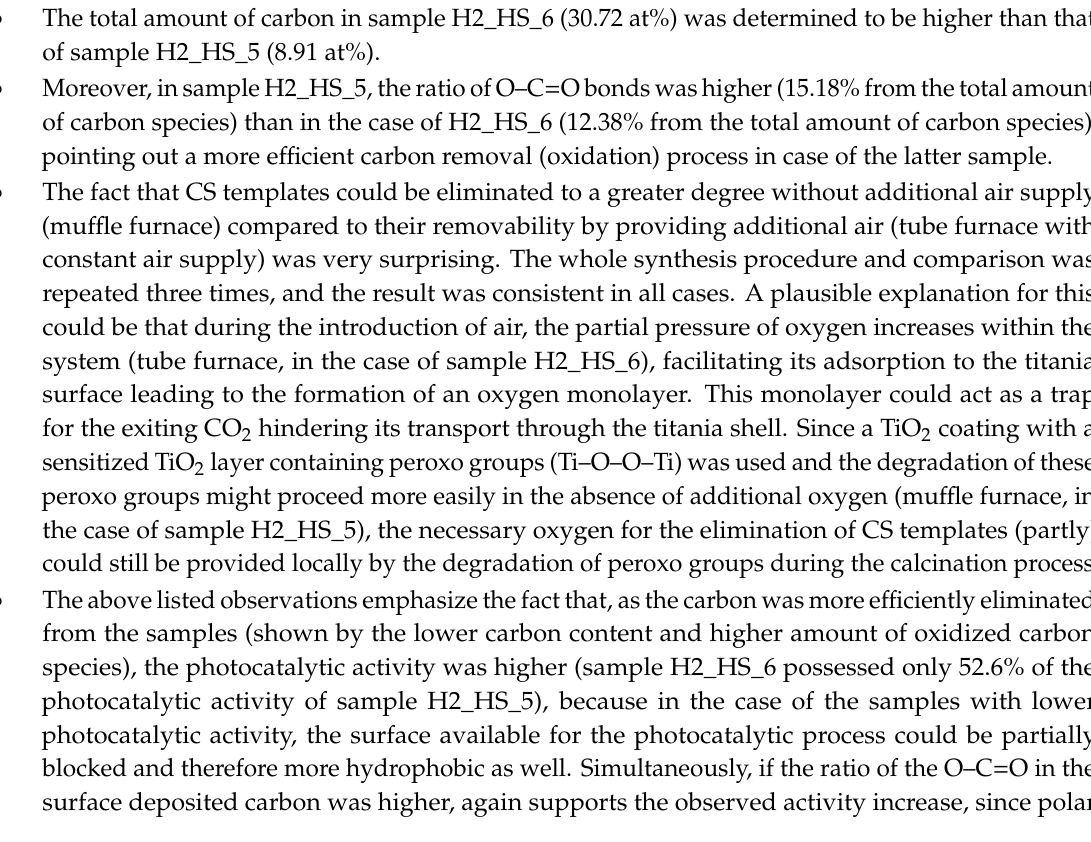
Figure 14. The core X-ray photoelectron spectroscopy (XPS) spectra of samples H2_HS_5 ( a ) Ti2p; ( b ) O1s; ( c ) C1s), H2_HS_2 ( d ) C1s, and H2_HS_6 ( e ) C1s pointing out the influence of the calcination and/or the quality of the carbon spheres on the surface chemistry of the titania hollow spheres. Comparing sample H2_HS_6 with H2_HS_5 the following observations were made.